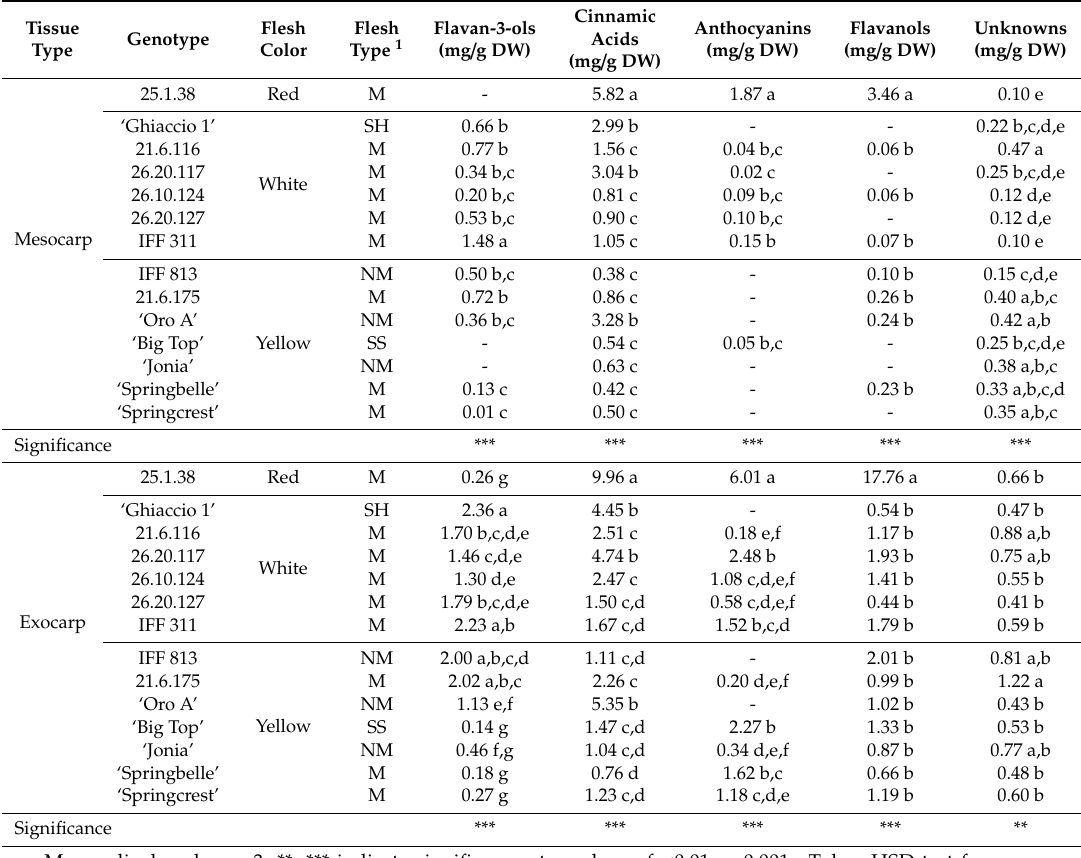
Table 3. Impact of flesh color, typology and sample tissue type (mesocarp and exocarp) on phenolic composition in peach / nectarine commercial cultivars and breeding accessions in 2007. Phenolic group classifications detected include: flavan-3-ols, cinnamic acids, anthocyanins, flavanols and unknown compounds identified with high-performance liquid chromatography